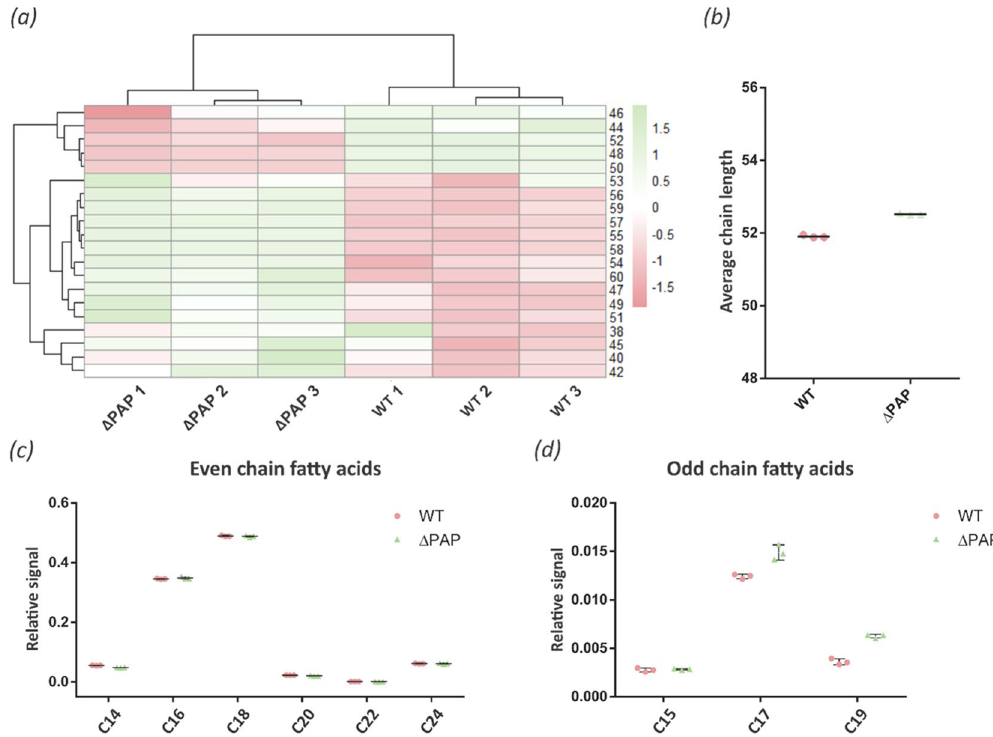
Figure 6. TAG composition of M. smegmatis WT and ΔPAP strains grown in 7H9 medium at pH 7. ( a ) Heatmap of the fatty acyl chain length variations in TAG extracted at exponential phase (T2, OD 600nm ~ 0.5) from cultures of the WT and ΔPAP strains grown in 7H9 medium at pH 7. ( b ) Weighted average of numbers of carbon in TAG’s chain. ( c ) Relative abundance of TAG with even fatty acid chain. ( d ) Relative abundance of TAG with odd fatty acid chain. WT, M. smegmatis mc 2 155 wild type strain. The results are the mean values and standard deviation of three independent biological replicates (WT1, WT2, WT3 and ΔPAP1, ΔPAP2,